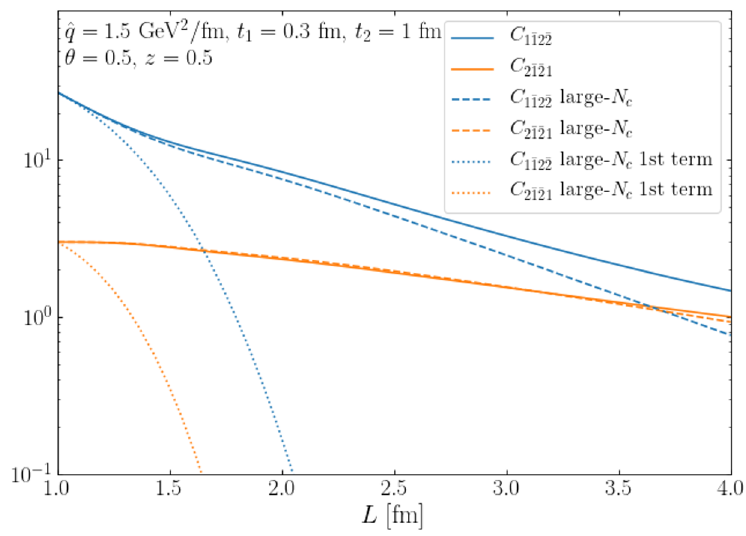
Figure 8. The exact and large- N c version of C 1¯12¯2 = h tr[ V 1 V †